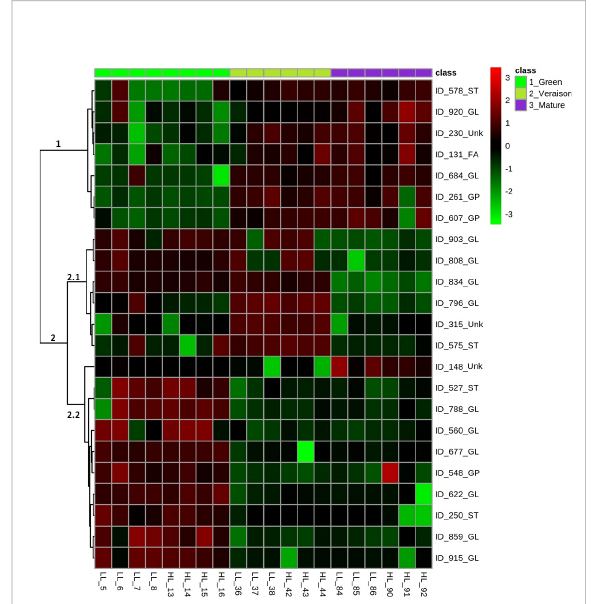
FIGURE 3 Heatmap with the 23 most signi fi cant seed lipids affected by grape berry developmental stages. On the left-hand side of the heatmap, the numbers represent the main clusters of the heatmap. On the right-hand side, the individual lipid compounds are represented by their LCMS number (e.g. ID_578) followed by the abbreviation of their lipid category: ST, Sterols; GL, Glycerolipids; FA, Fatty Acyls; GP, Glycerophospholipids; Unk, unknown. Samples and developmental stages are also indicated: the three developmental stages on top of the heatmap and ordered from left to right as green (light green color), veraison (darker green color) and mature (purple color), while the biological replicates for low light (LL) and high light (HL) are indicated at the bottom ( n = 4 for green stage and n = 3 for veraison and mature stage each). Color scale on the top-tight of fi gure indicates the relative abundance of the lipid compounds in the samples, after logarithm data transformation (scale from -3 to +3, indicates a relatively low and high abundance,